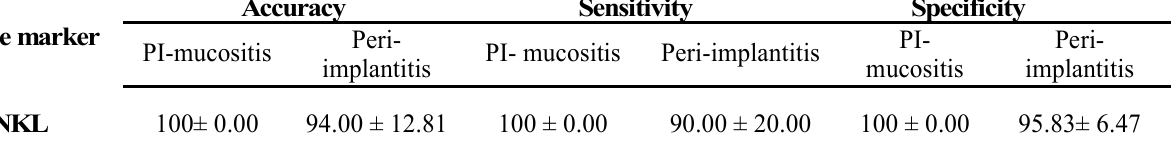
Figure 2. Diagnostic capacity of RANKL for diagnosis of peri-implant diseases. RANKL concentra- tions were significantly increased in peri-implant mucositis and peri-implantitis when compared to healthy controls, while there was no significant difference between two peri-implant diseases. Based on estimated diagnostic performance, RANKL answered request for diagnostic marker of peri-implant diseases. PI-mucositis-peri-implant mucositis; *- p < 0.05; diagnostics performance values are expressed as mean % and standard deviation.